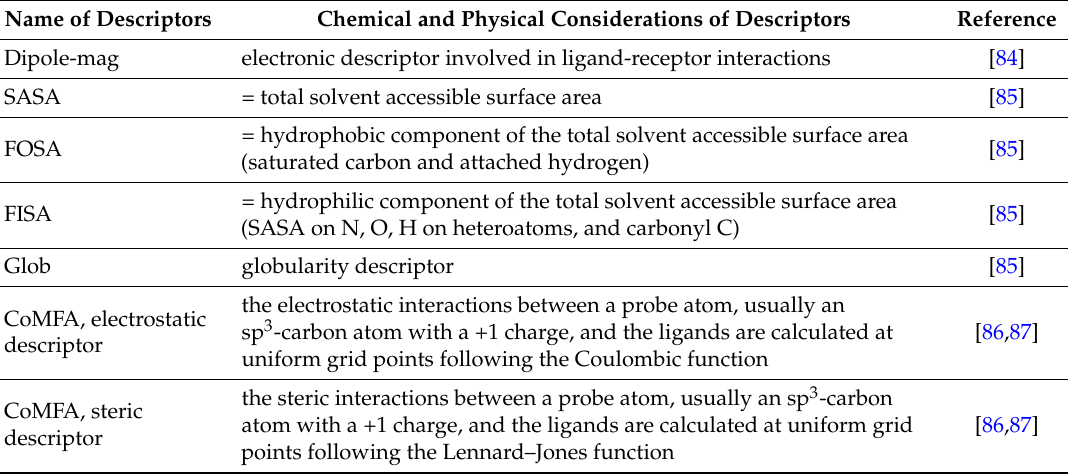
Table 1. Symbols and chemical and physical considerations of significant molecular descriptors of the antidepressants.